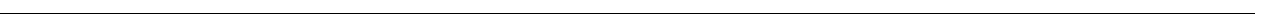
Fig. 6 Molecular model of LFA-1 orientation on the cell surface. a Schematic of the integrin-microscope reference frame. b , c Details of the integrin- microscope reference frame. xy and xz planes are black and blue grids, respectively. Integrin C α atoms used to de fi ne the origin (red), x axis (gold), and xz plane (silver) are shown as large spheres. The GFP transition dipole (red) and its projection on the image plane (yellow – orange) are shown as cylinders with cones at each end. A spherical coordinate radial marker r (red arrow) is used to compare integrin orientations between the reference state with θ = 0° and ϕ = 90° b and integrin orientation with θ = 0° and ϕ = 45° that fi ts data well c . Inset shows relation between Cartesian coordinates and spherical coordinates with ϕ measured between the z axis and radial marker (r) and θ measured between the projection of r in the xy plane and the x axis. d , e The image plane with dipole positions of Rosetta ensemble members (lowest 40% in energy) projected from a spherical surface and shown as open gray circles for α L-T d and α L-F e . Projections are shown in the reference frame with θ = 0° and tilts in ϕ ranging from 11.25 to 67.5°. Silver, red, and gold circles show the same integrin reference atoms as in b & c . The calculated ensemble transition dipole 57 is projected as a green line with length proportional to p . The transition dipole orientation determined by FluoPolScope is shown as black line with ± 1 s.d. shown as dashed lines. f Schematic showing integrin and GFP dipole orientation relative to tensile force between the actin cytoskeleton and ICAM (arrows) in migrating cells. g Model of cytoskeletal force acting on an integrin drawn to scale tilted at ϕ = 45°. Structures 15,20 – 22,56,58 – 60 were assembled and rotated at domain – domain junctions known to be fl exible and depicted with